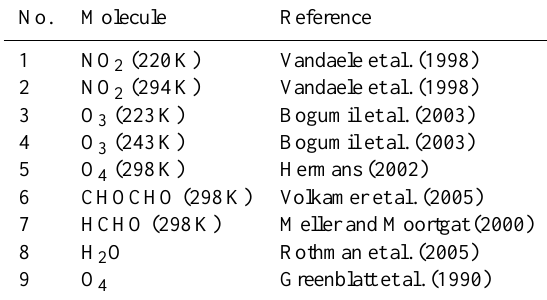
Table 1. List of trace gas references used for DOAS